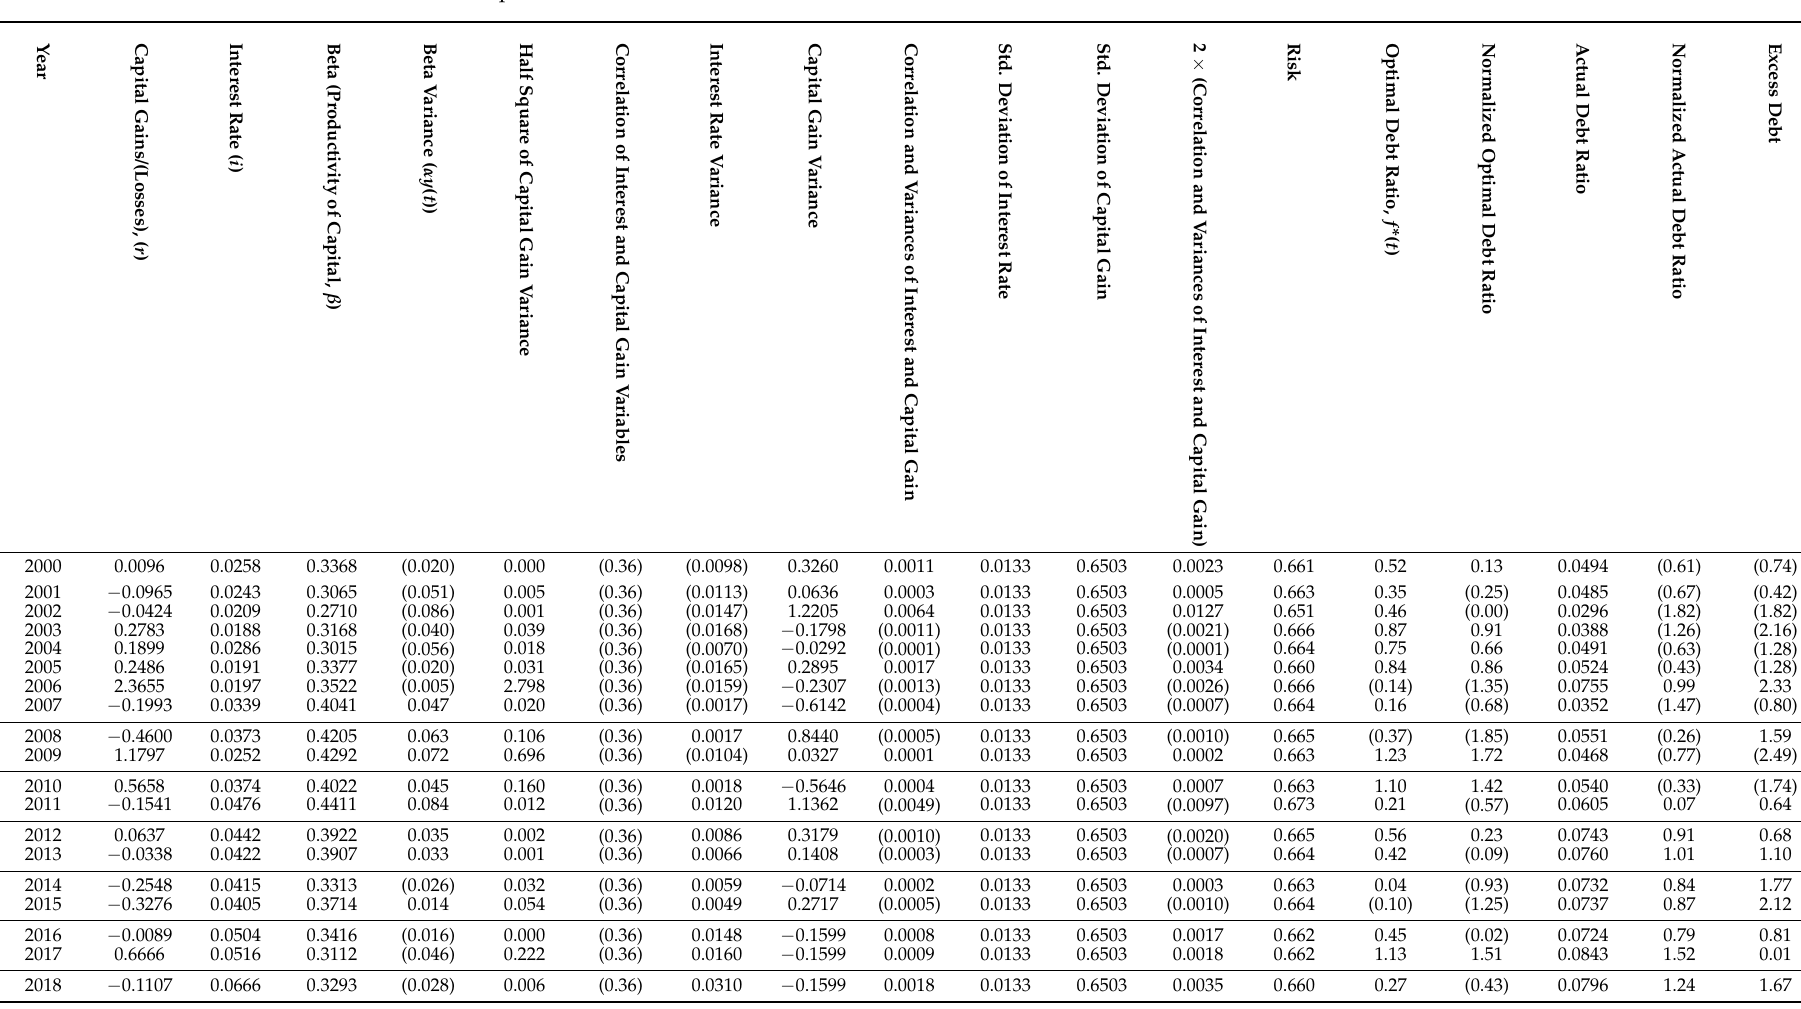
Table A2. Calculations of Optimal and Excess Debt: CIMB Islamic